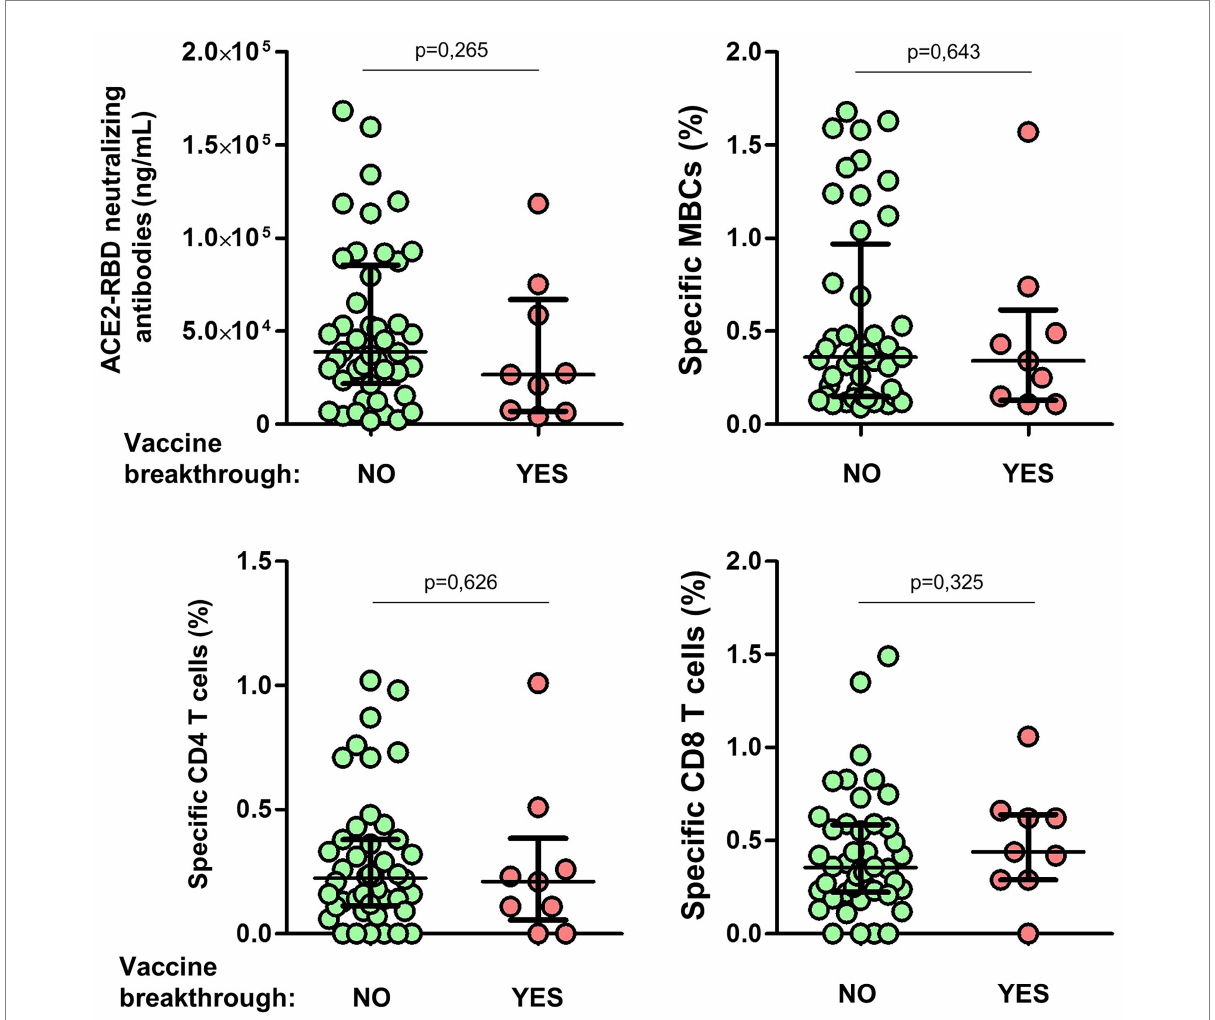
FIGURE 10 Differences of ACE2-RBD neutralizing antibodies, specific memory B (MBCs) and T cells levels according to subsequent vaccine breakthrough. Mann–Whitney